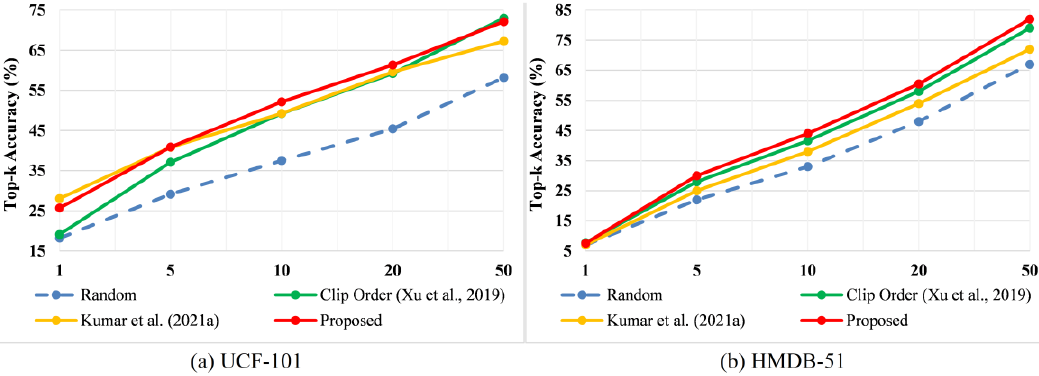
Figure 3. Video retrieval results (top-k accuracy %) on UCF-101 and HMDB-51.